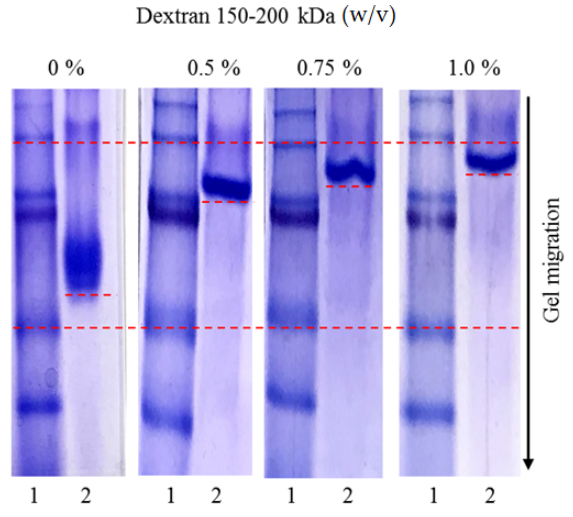
Figure 7. Affinity gel electrophoresis of r – Tm DEX49A– ∆ SP– ∆ N30 in polyacrylamide gels (PAGE under native conditions) with different concentrations of dextran. The dextran concentration is expressed in % ( w/v ). Lanes 1: molecular weight marker (PageRuler™ Prestained Protein Ladder, Thermo Scientific™, USA); lanes 2: K. phaffii DEX49A – Δ SP – Δ N30 supernatant (end time of fermentation in FM21 – PTM1 medium).